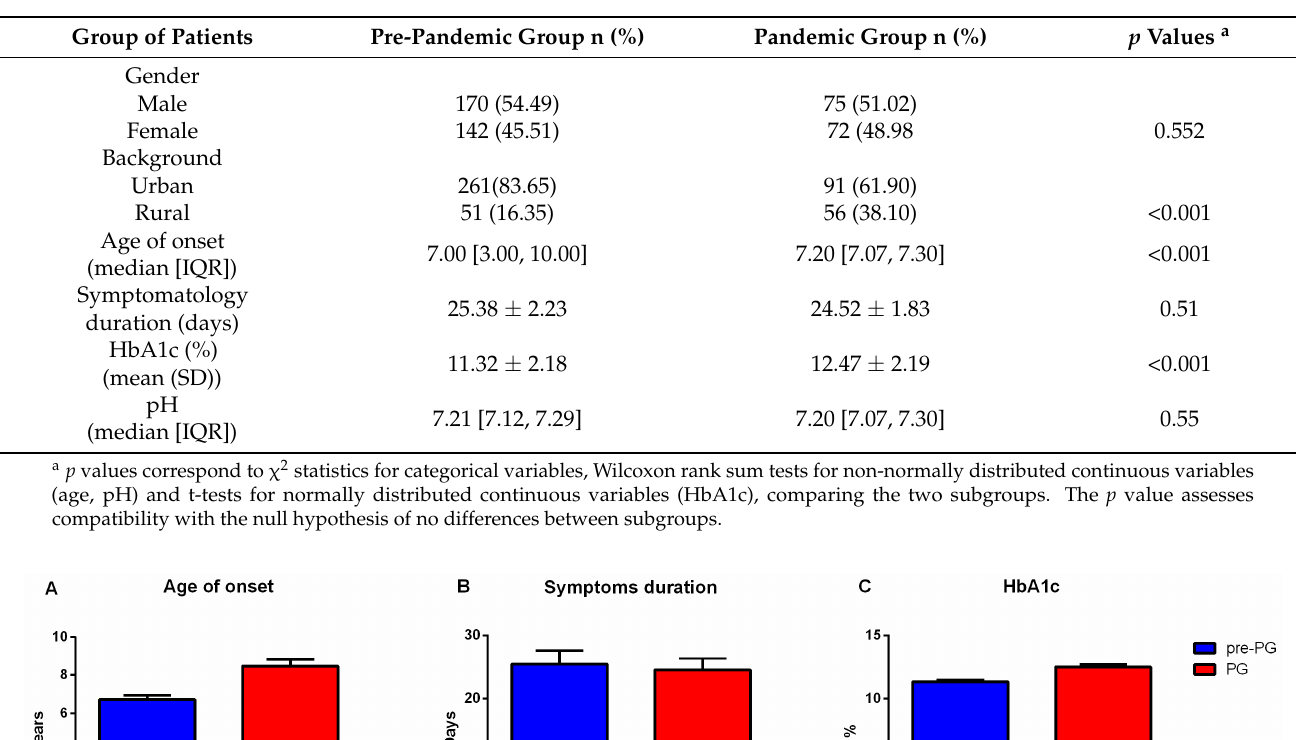
Table 1. Characteristics of the study sample according to the time of diagnosis.